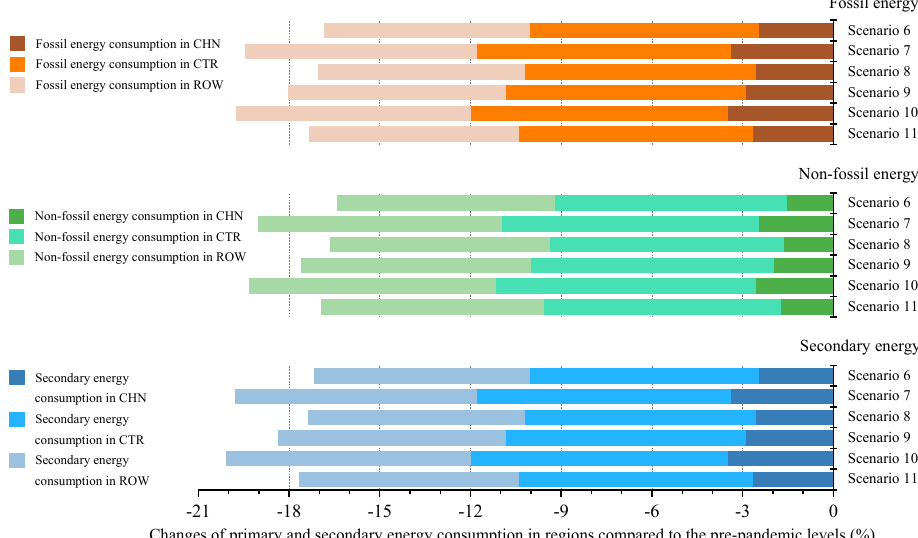
Figure 9. The impact of global pandemic spread on primary and secondary energy consumption in trade regions in the context of trade protectionism.